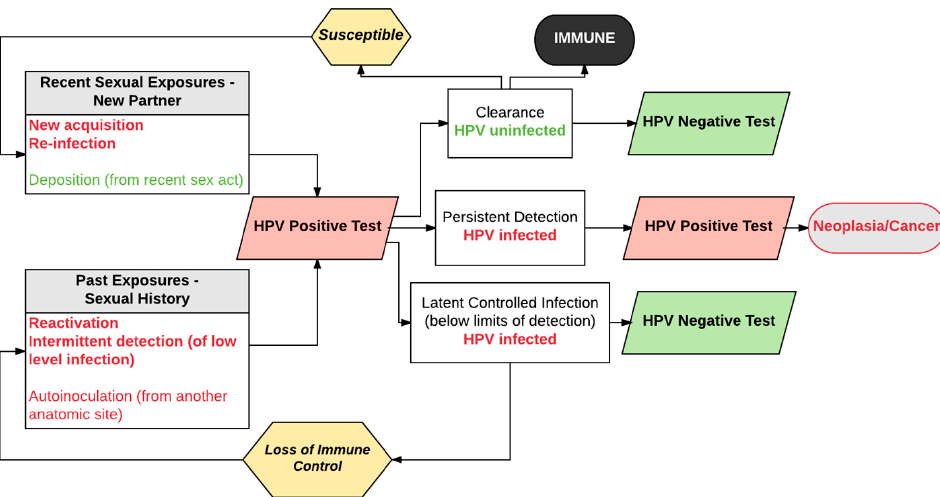
Figure 2. Schematic model of individual-level natural history of female genital HPV infection across the life span. The model assumes two pathways to type-specific HPV positivity after an HPV-negative test result—new acquisition or reinfection due to current sexual activity, or reactivation/recurrent detection of controlled, latent HPV infection. Red boxes indicate positive HPV molecular test results and green boxes indicate negative HPV molecular test results. Colored fonts represent the true underlying infectious status independent of concurrent molecular test results from exfoliated samples; red = HPV infection, green = HPV uninfected.